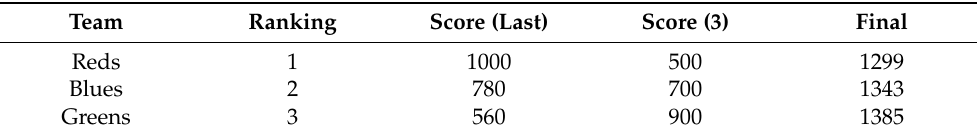
Table 3. Tournament